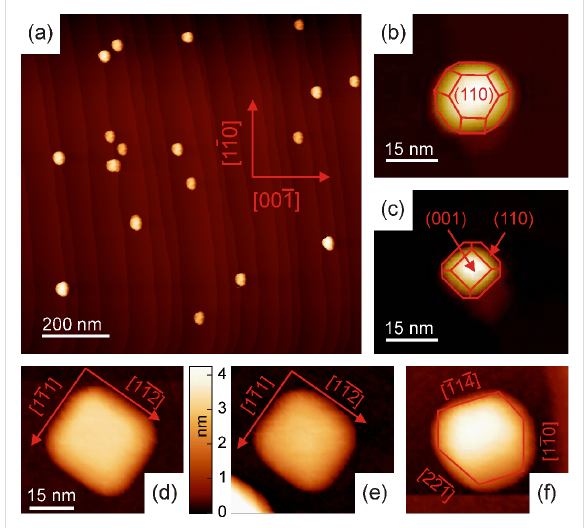
Figure 4: (a) STM image of mass-filtered Fe nanoparticles (mean diameter of 7 nm) deposited onto W(110). Tunneling parameters: U = 1.0 V, I = 0.5 nA. (b) and (c): Tip deconvolution of the STM images reveals surface facets consistent with the random orientation as